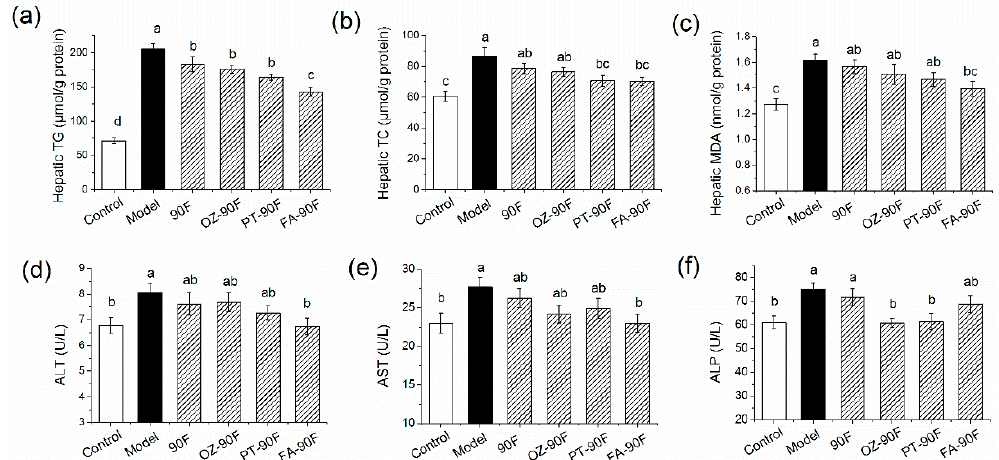
Figure 5. E ff ect of enriched flour on hepatic lipid and MDA accumulation and hepatic function in rats. At the end of the study, the hepatic tissue was dissected and homogenated for the measurement of hepatic TG ( a ), TC ( b ), and MDA ( c ). Blood samples were collected from orbital venous at week 16 from 12-h fasted rats for the measurement of serum ALT activity ( d ), AST activity ( e ), and ALP activity ( f ). Data are presented as mean ± SEM ( n = 10). Mean values with di ff erent letters are significantly di ff erent ( p < 0.05). 90F, 90% wheat flour; OZ-90F, γ -oryzanol enriched 90% wheat flour; PT-90F, phytosterol enriched 90% wheat flour; FA-90F, ferulic acid enriched 90% wheat flour.